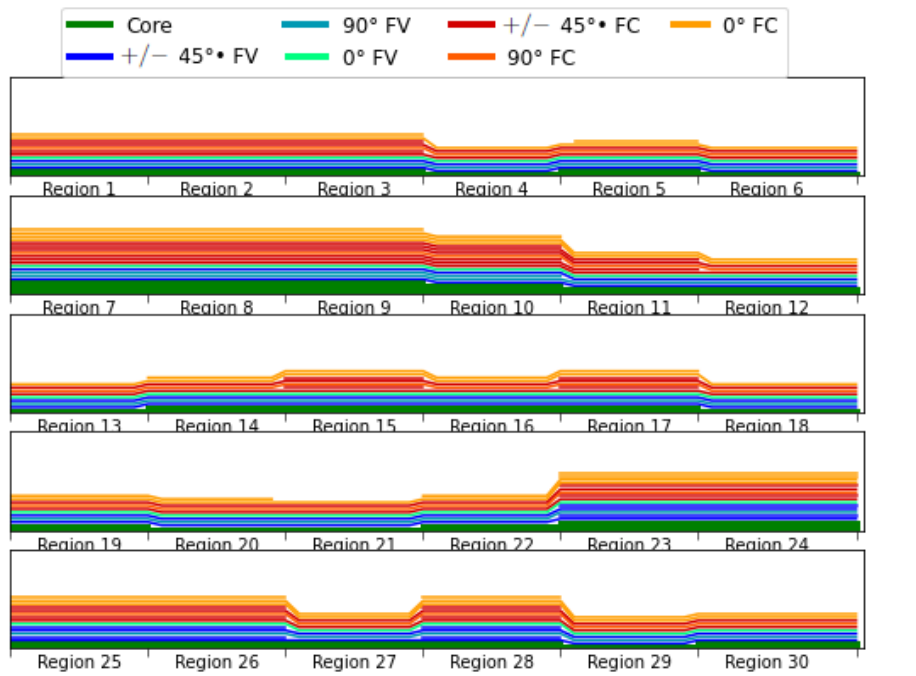
Figure 10. Schematic representation of the laminate selected through MCDM from the MOSOP1 PF.